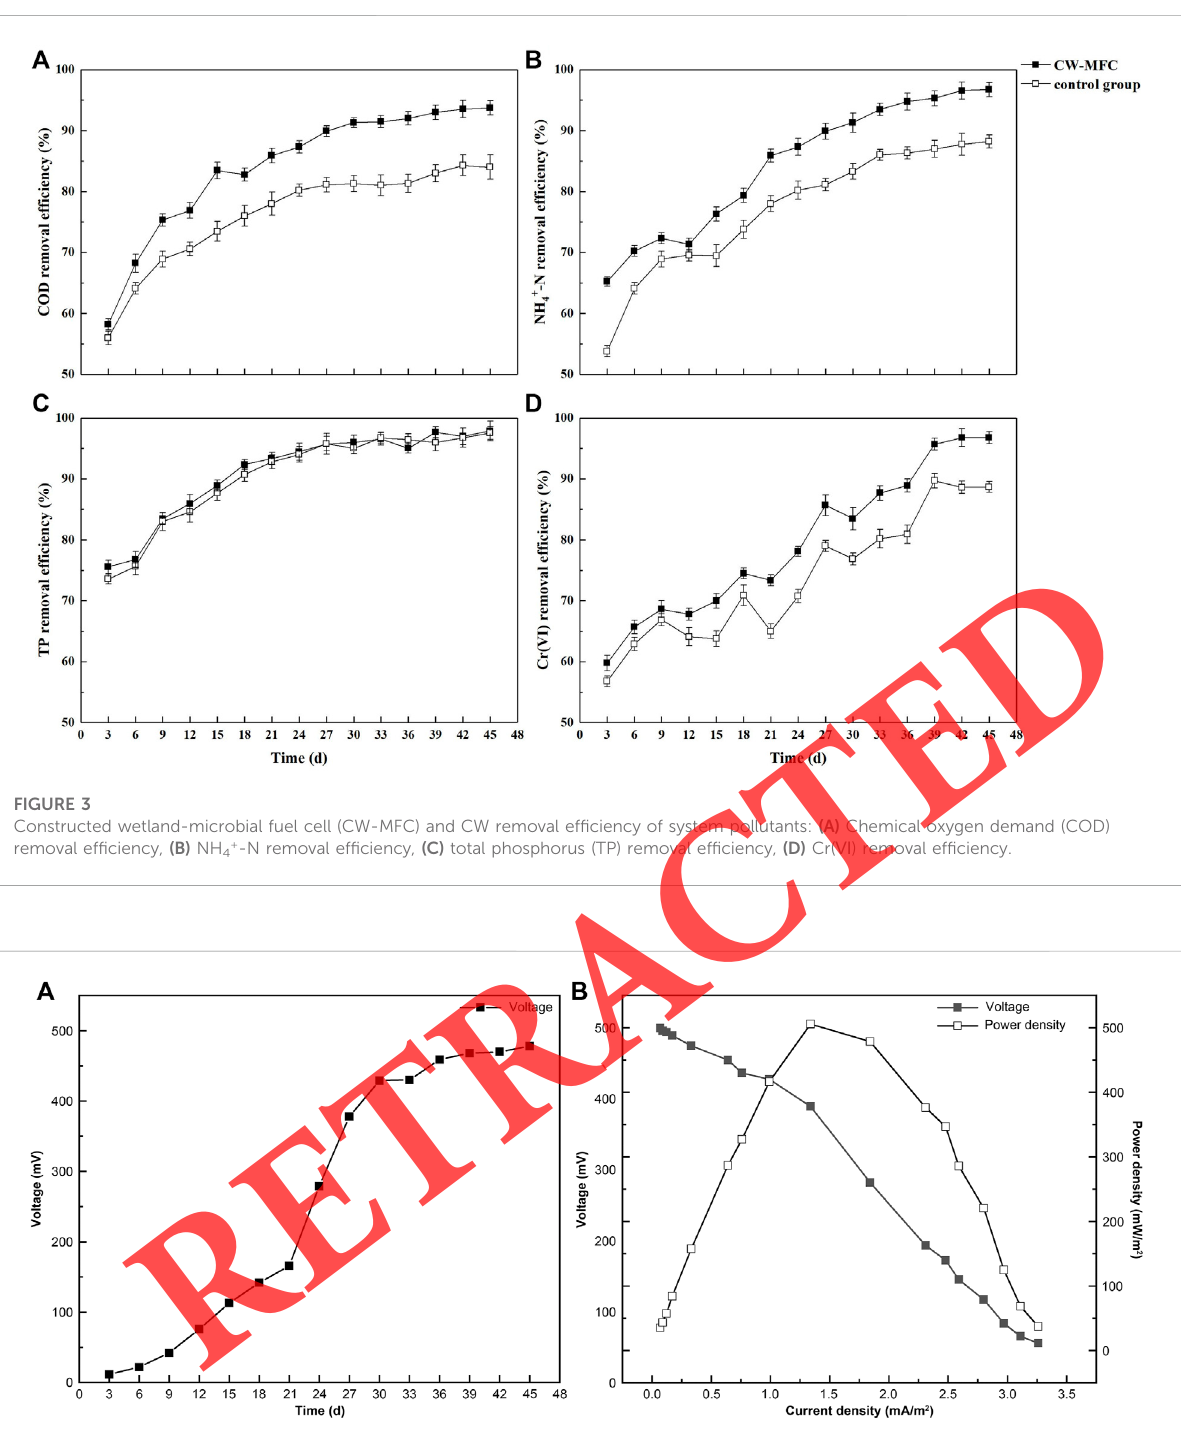
Constructed wetland-microbial fuel cell (CW-MFC) system power generation: (A) CW-MFC system voltage, (B) power density curve and polarization curve of the CW-MFC